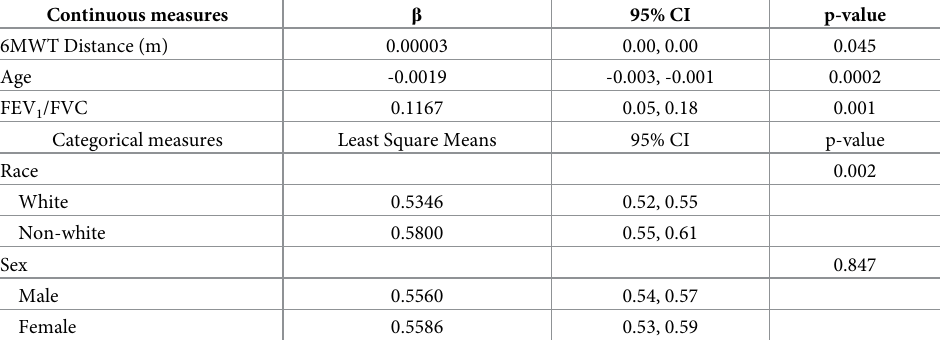
6MWT = 6-minute walk test. Generalized linear models were constructed with leukocyte telomere length as the independent variable and 6MWT as the independent variable, with adjustment for age, FEV 1 /FVC ratio,